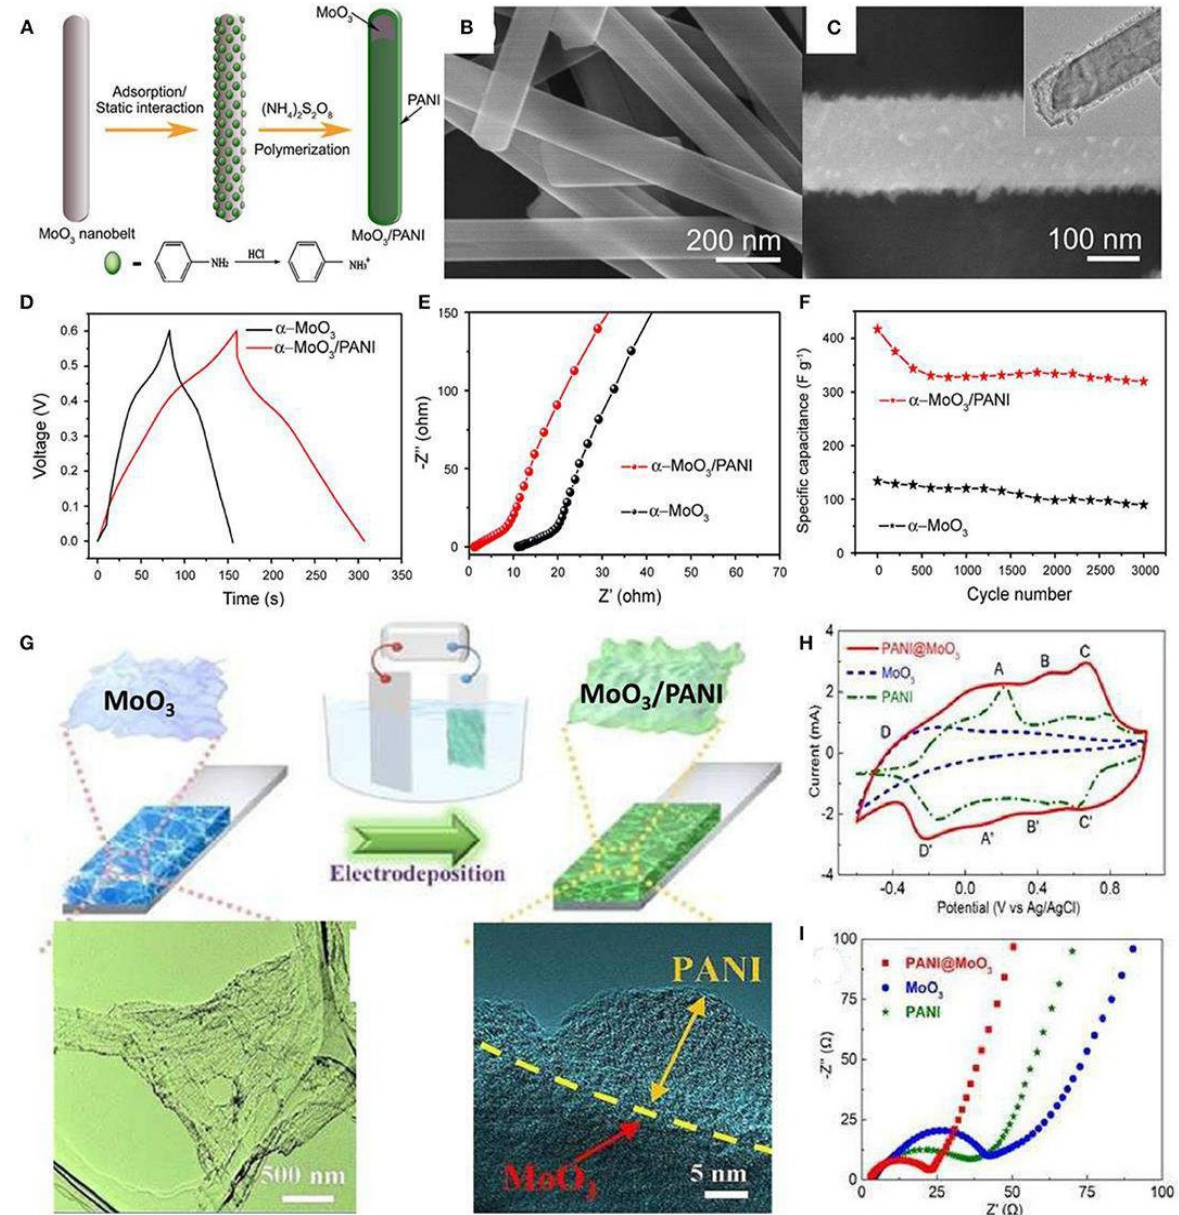
Figure 15. ( A ) Schematic illustration of the formation of the MoO 3 /PANI coaxial heterostructure nanobelts. ( B ) SEM images of the original α -MoO 3 nanobelts. ( C ) SEM images and (inset) TEM images of the as-synthesized MoO 3 /PANI coaxial heterostructure nanobelts. ( D ) A comparison of the galvanostatic charge–discharge curves of the two comparative materials at a current density of 2 A/g. ( E ) EIS spectra comparison and ( F ) cycling performance at a scan rate of 50 mV/s of the two comparative materials. ( G ) Schematic illustration for the synthesis process of 3D MoO 3 /PANI hybrid nanosheet network film. ( H ) CV curves of MoO 3 , PANI, and 3D MoO 3 /PANI hybrid nanosheet network films in the potential range from − 0.6 to 1 V at a scanning rate of 50 mV/s. ( I ) Nyquist plots of the MoO 3 , PANI, and 3D MoO 3 /PANI hybrid nanosheet network films. Reproduced with permission from